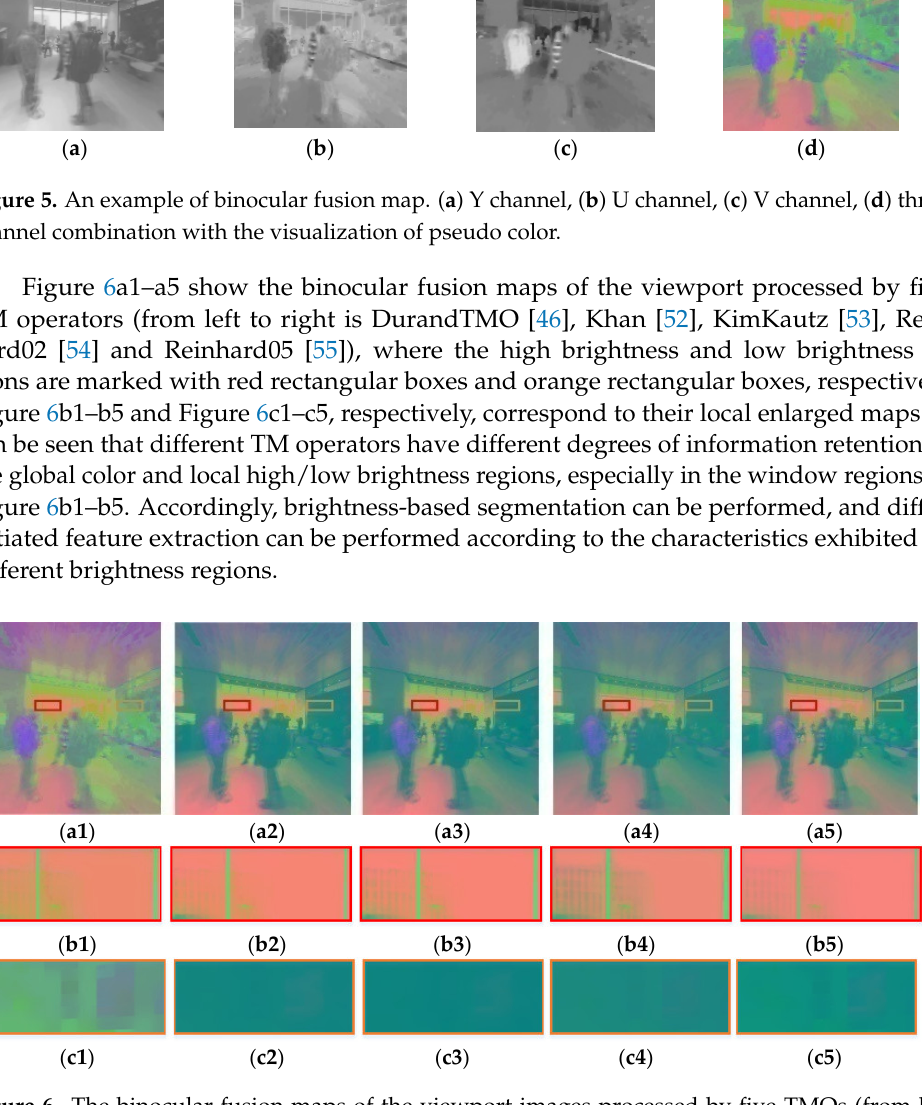
Figure 6. The binocular fusion maps of the viewport images processed by five TMOs (from left to right is DurandTMO [46], Khan [52], KimKautz [53], Reinhard02 [54] and Reinhard05 [55]). ( a1 – a5 ) Binocular fusion maps; ( b1 – b5 ) Partially enlarged maps of highlighted regions, corresponding to the red rectangular boxes in ( a1 – a5 ); ( c1 – c5 ) Partially enlarged maps of low–dark regions, corresponding to the orange rectangular boxes in ( a1 – a5 ).